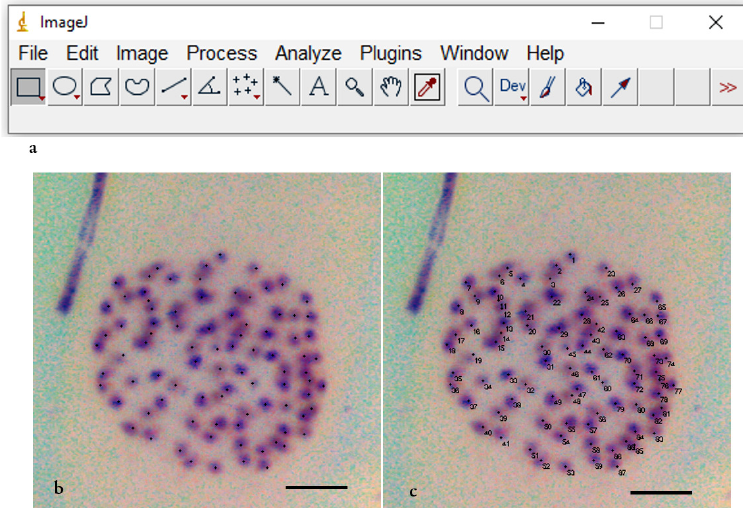
Figure 6. Digital counting: (a) ImageJ software toolbar, (b) marked chromosomes of octoploid of N.